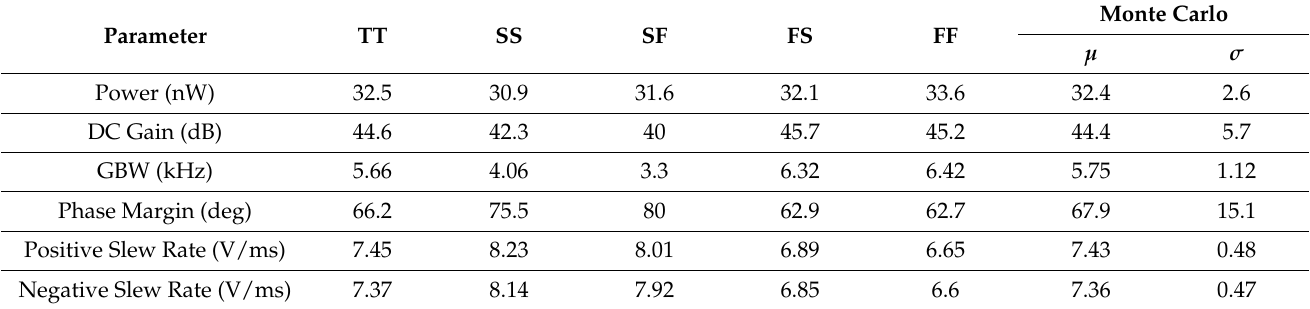
Table 4. Corner and Monte Carlo analysis results for T = 27 ◦ C.